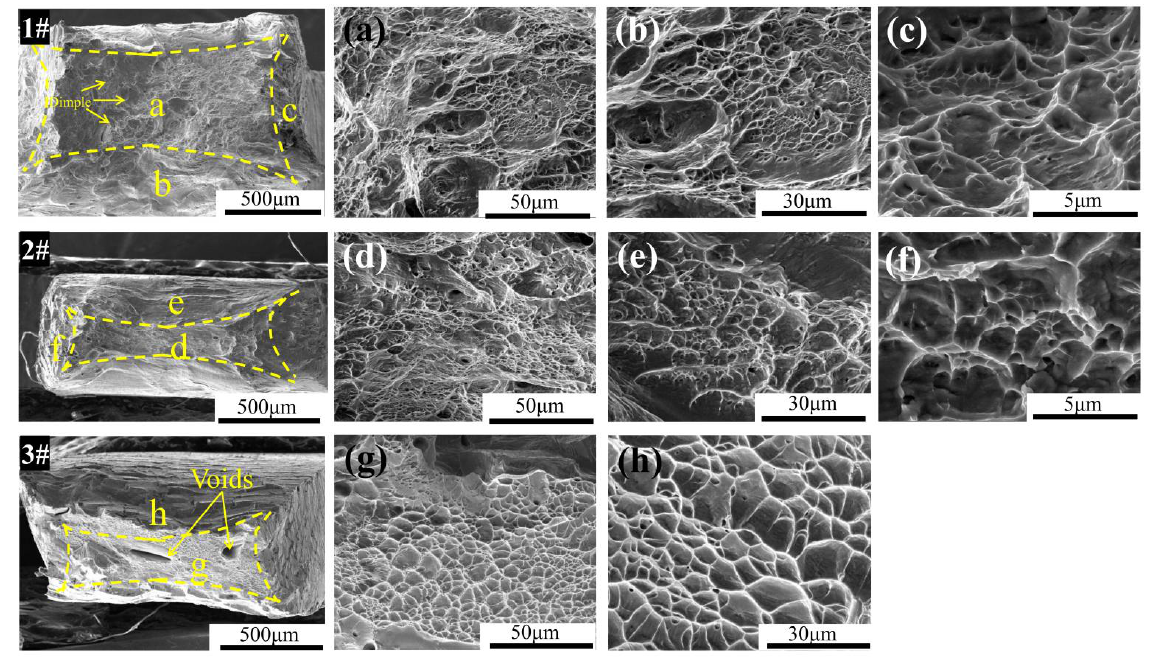
Figure 4. SEM images of fracture morphology for samples Zr 40 Nb 35 Ti 25 ( 1# ), Zr 50 Nb 35 Ti 15 ( 2# ), and Zr 60 Nb 35 Ti 5 ( 3# ) after tensile tests. ( a – c ) are enlargements of the zones labeled “a”, “b“, and “c” in the sample 1#, respectively. Correspondingly, ( d – f ) are the local enlargements of the sample 2#, and ( g , f ) is the local enlargements of the sample 3#.